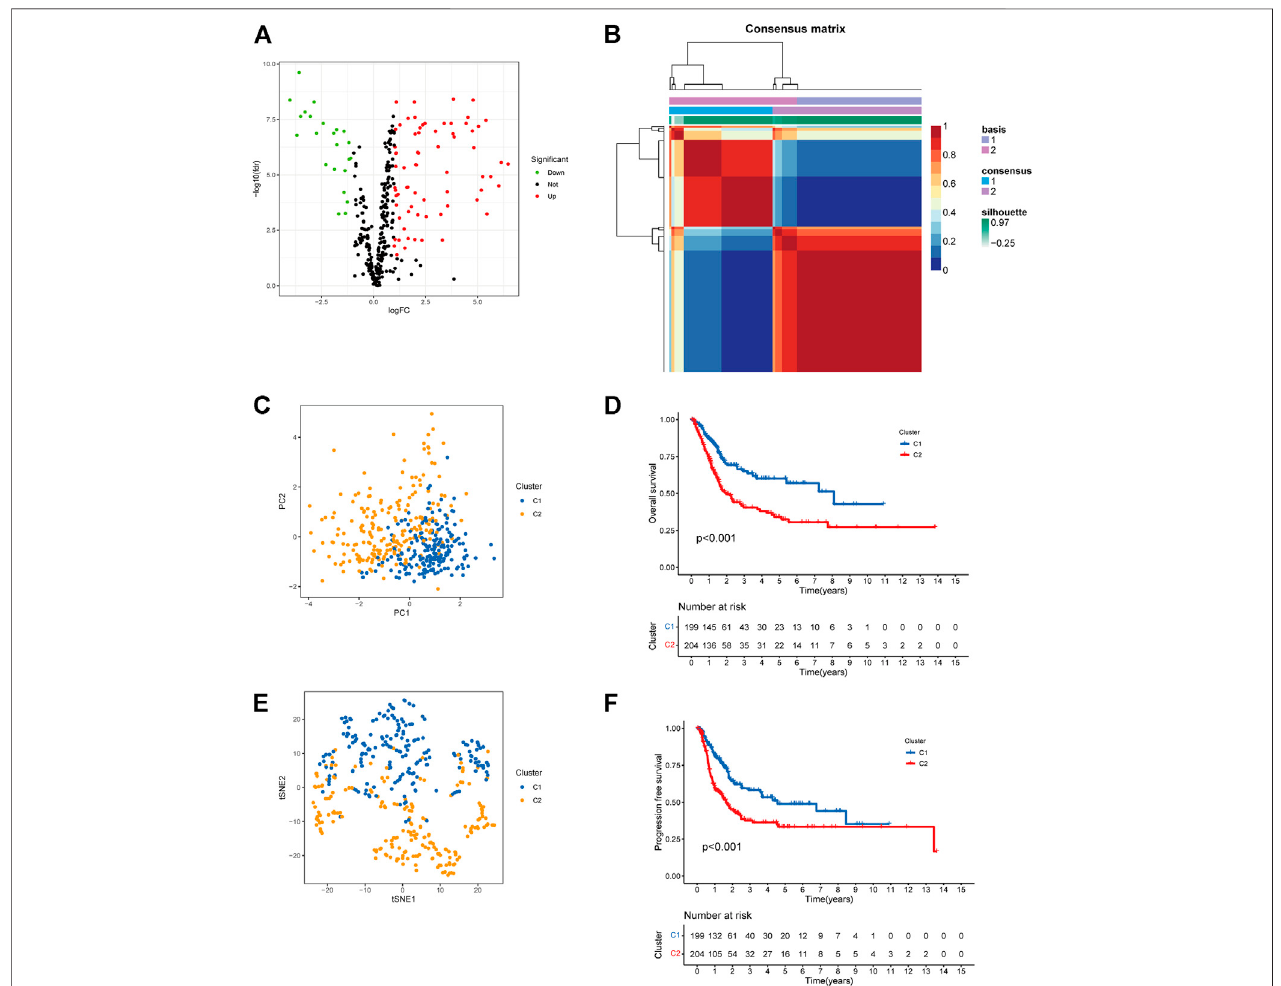
FIGURE 1 | Cluster subtypes were identi fi ed. (A) Volcano map displayed the differentially expressed Notch pathway-related genes in TCGA-BLCA. Red: up- regulation, blue: down-regulation. (B) NMF clustering consensus map. (C) PCA plot in the two cluster groups. (D) t-SNE analysis in the two cluster groups. (E) Overall survival analysis of two clusters. (F) Progression-free survival analysis of two